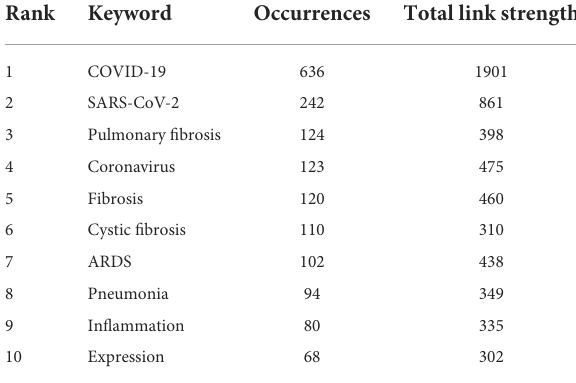
TABLE 1 The ranking of the top 10 keywords with largest occurrences in the field of COVID-19-associated